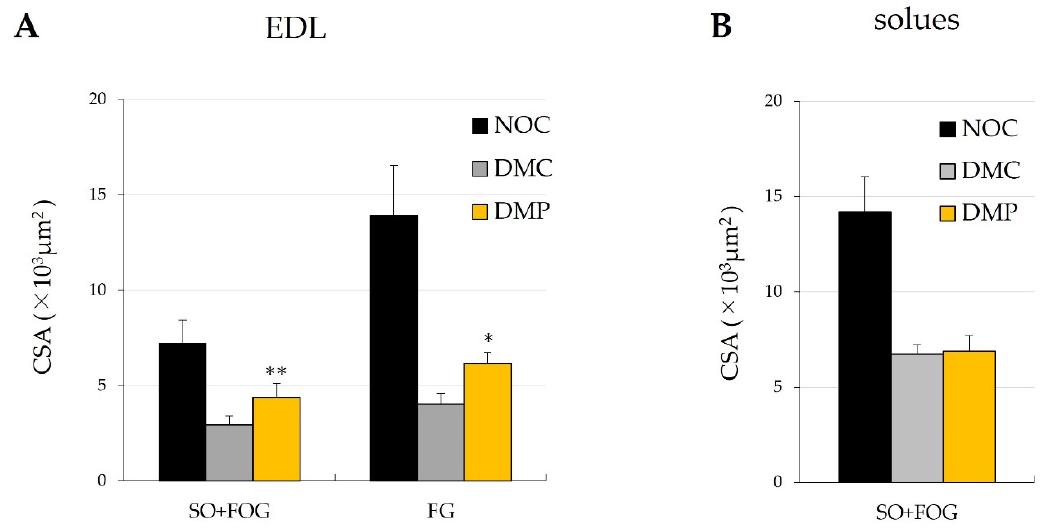
Figure 7. Cross-sectional area (CSA) of each fiber type in extensor digitorum longus (EDL) ( A ) and soleus ( B ) muscles in normal and diabetes rats. NOC: normal rats fed a control diet, DMC: diabetic rats fed a control diet, DMP: diabetic rats fed the non-extractable fraction of dried persimmon (NEP) diet. SO: slow-twitch oxidative type of muscle fiber, FOG: fast-twitch oxidative glycolytic type of muscle fiber, FG: fast-twitch glycolytic type of muscle fiber. Data are presented as the means ± SD of each animal in each group. ** p < 0.01 significantly different from the DMC group. * p < 0.05 significantly different from the DMC group.